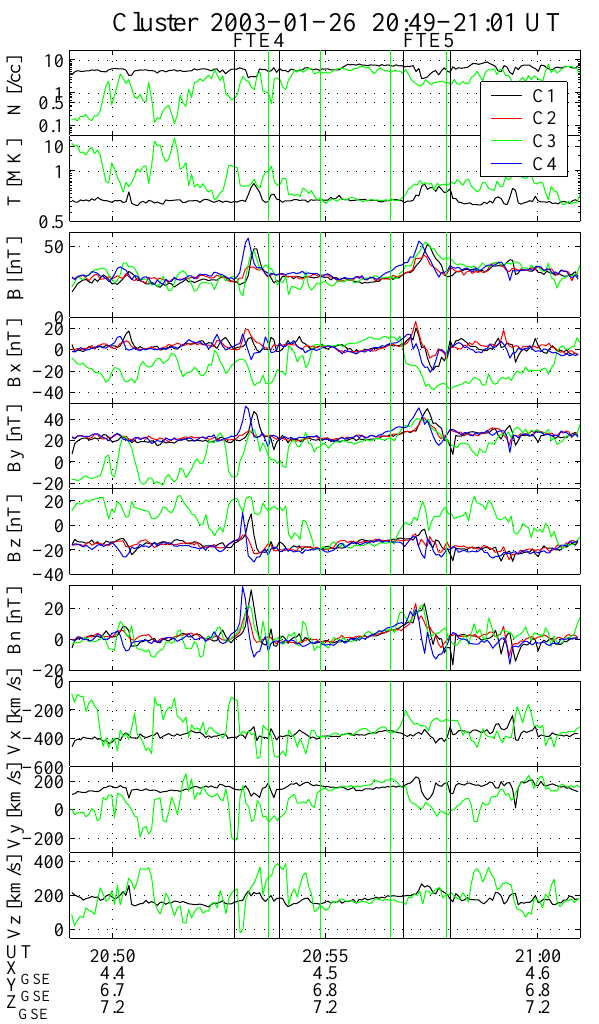
Fig. 7. Field and pressure maps and associated scatter plot for FTE